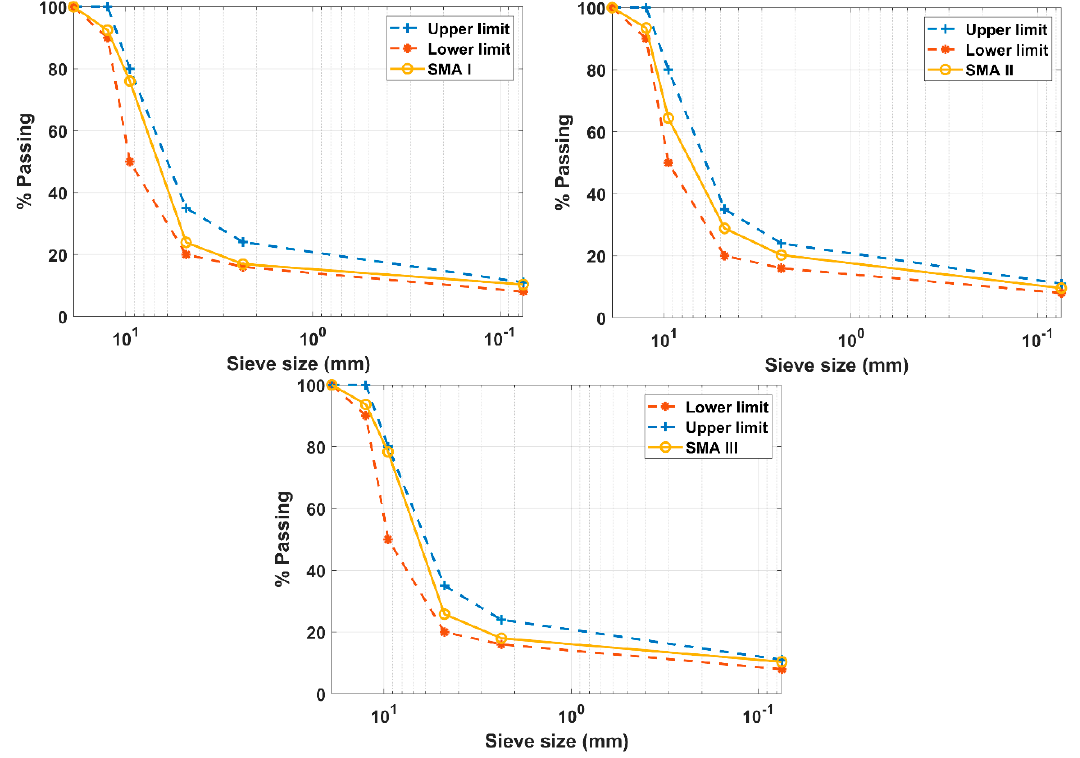
Figure 1. Mixture gradation aggregate for the SMA samples.